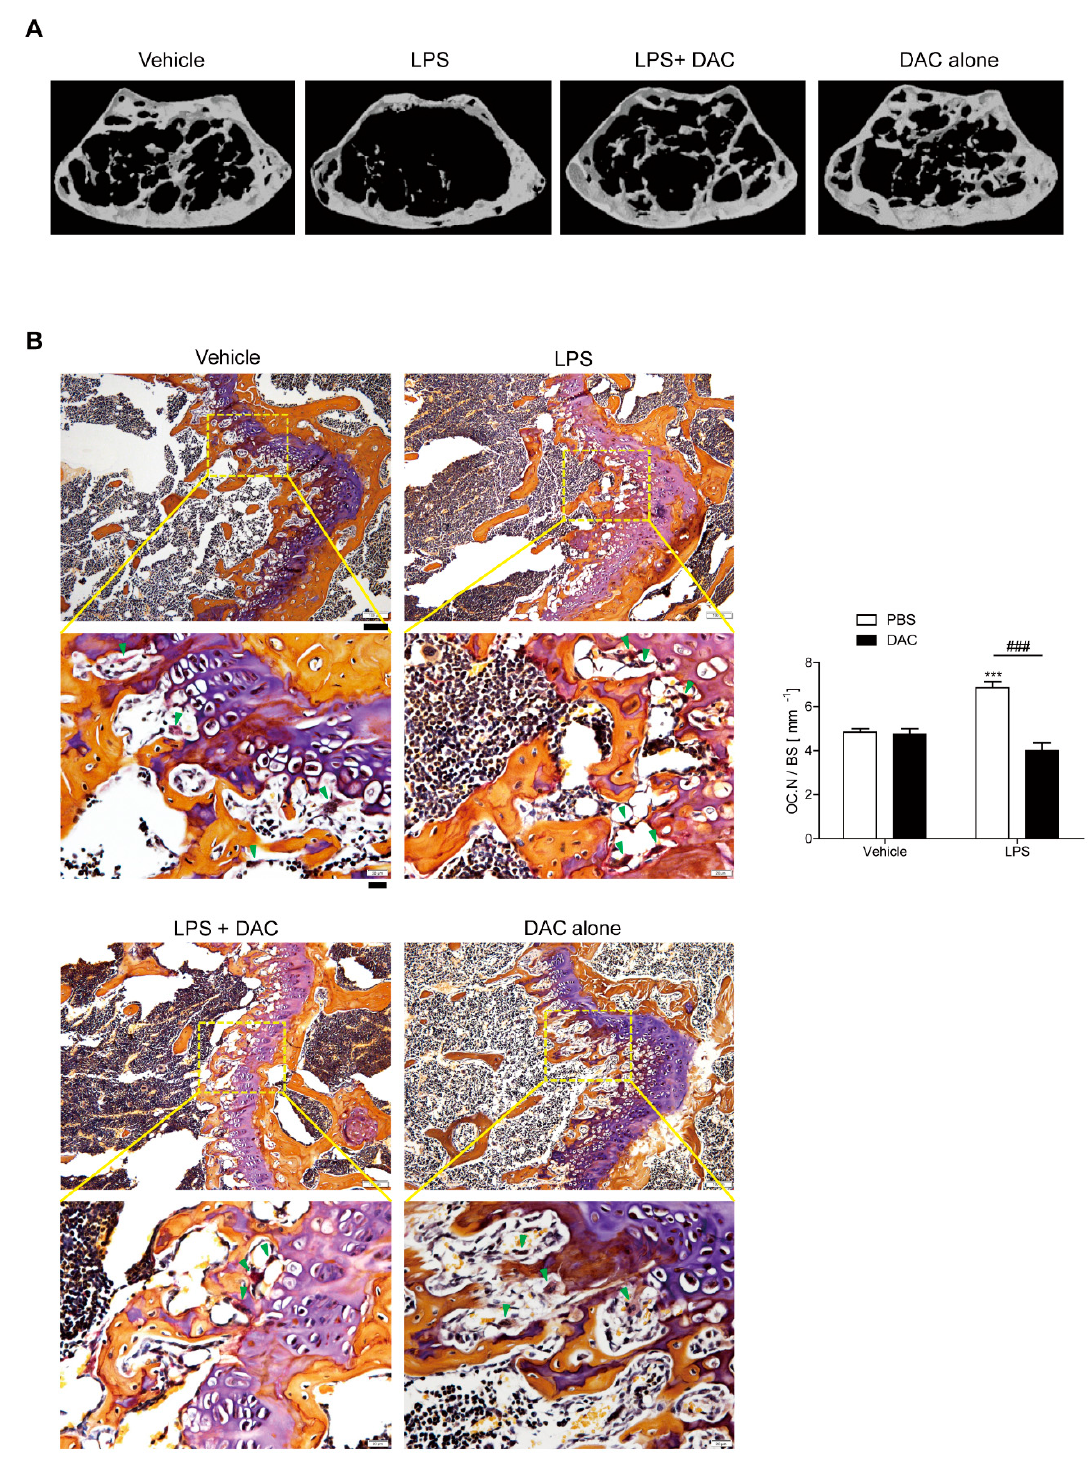
Figure 1. Dauricine (DAC) attenuates lipopolysaccharide (LPS)-induced bone loss in mice. ( A ) Representative µ CT images of distal femora in a region 0.45 mm in length and located 0.55 mm below the growth plate to show the density of the trabecular bone that represents the outcome of active bone remodeling. Mice were treated with PBS ( n = 5), LPS (5 mg / kg / week) ( n = 5), LPS + DAC (2.5 mg / kg / d) ( n = 5), or DAC only (2.5 mg / kg / d) ( n = 5). Mice were treated for 3 weeks beginning at the age of 10 weeks. ( B ) To examine tartrate-resistant acid phosphatase (TRAP)-positive osteoclasts (OCs) in vivo, mouse femora were excised, cleaned with a soft tissue, and decalcified in EDTA. Representative histological sections of the distal femoral metaphyses of mice from each of the 4